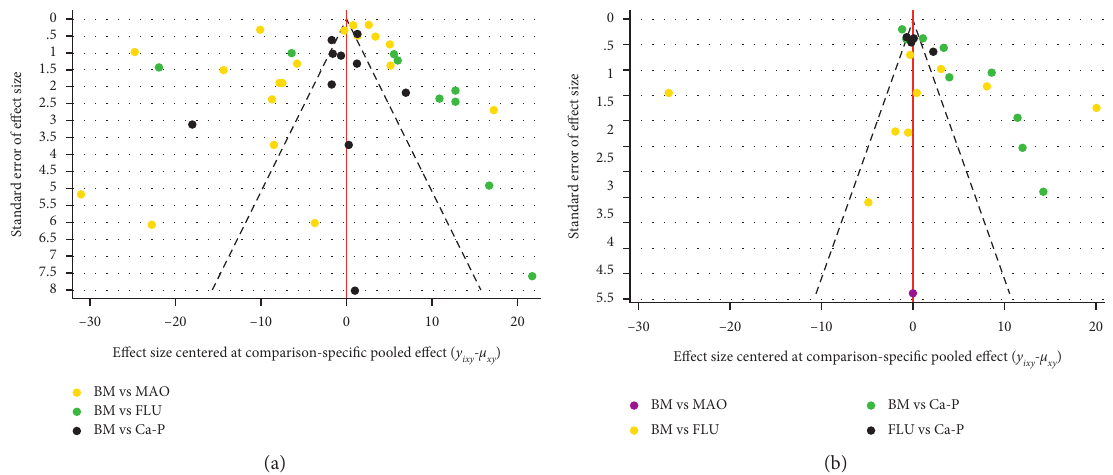
Figure 9: Funnel plot to investigate heterogeneity and publication bias: (a) % degradation and (b) new